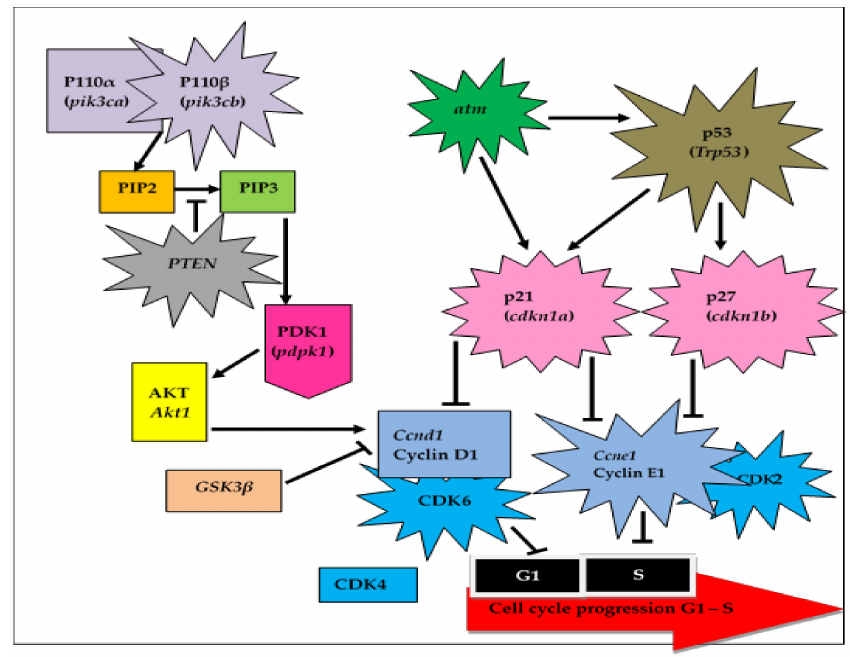
Figure 4. Alterations of the PI3K/Akt-Cyclin D1 pathway in cell cycle progression from G1 to S phase in 2-cell embryos. Concurrent treatment with nicotine and mixed/pure δ -TCT (Grp.3 & Grp.4)